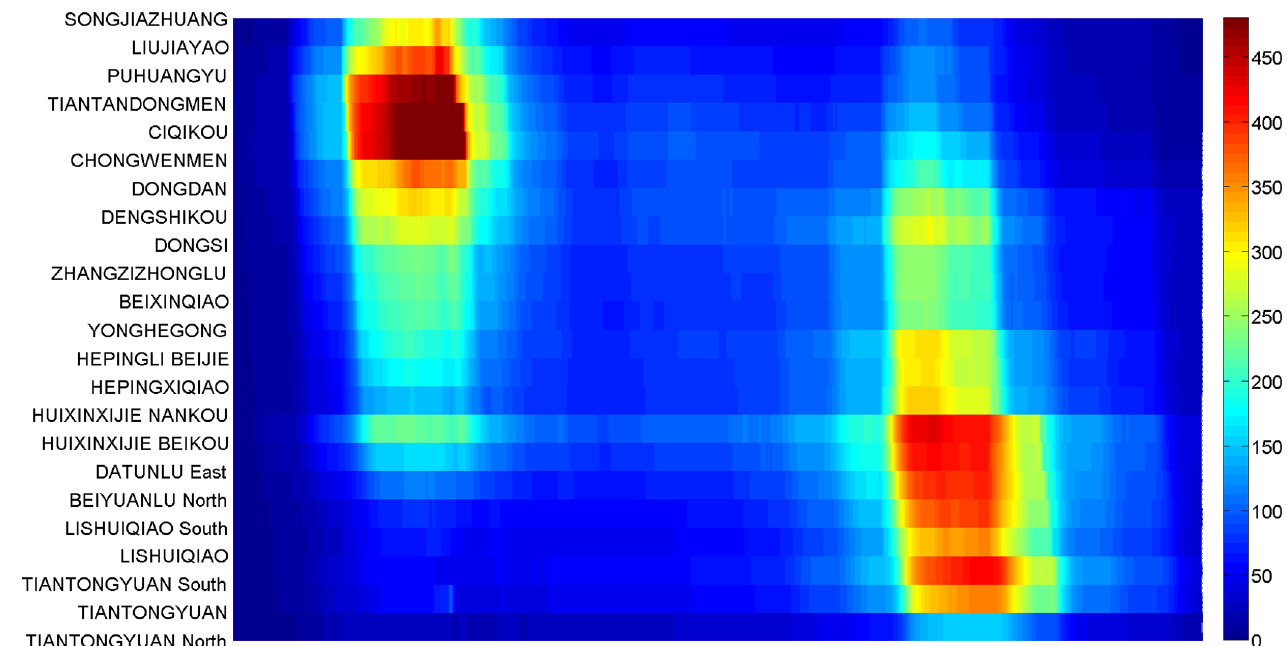
Fig 17. The space-time section flow distribution from Songjiazhuang to Tiantongyuan North.